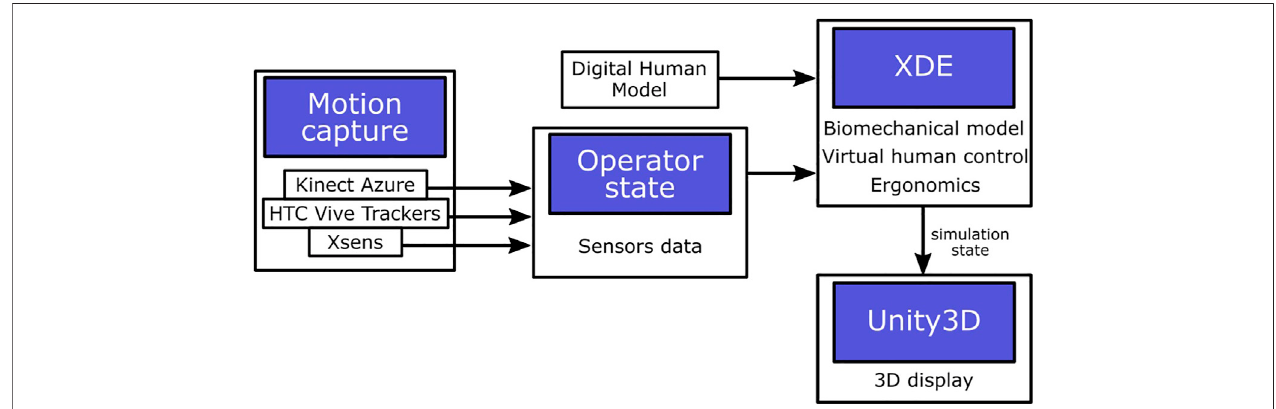
FIGURE6| Architecturefocusonoperatorsdigitaltwins.OperatorsstateisaccessedfrommotioncapturesensorsinrealtimeandsenttotheXDEphysicsengine to process in the physics simulation, before sending the simulation state to Unity3D for display.